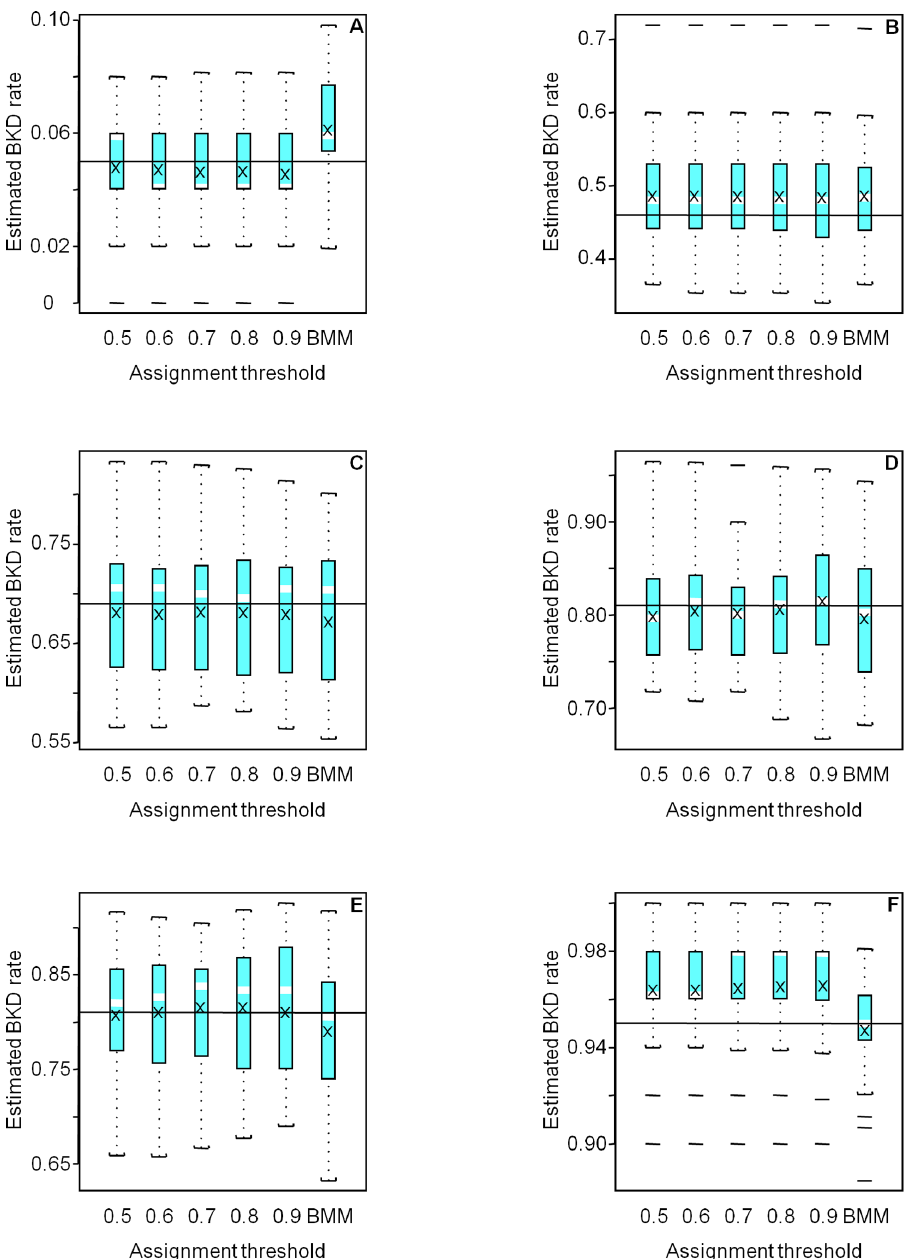
Figure 1. Boxplots of the estimated BKD prevalence rates for the 25 simulations of the positive case in Groups (A) 1, (B) 2, (C) 3, (D) 4, (E) 5, and (F) 6, using the individual assignment method and minimum assignment probability thresholds from 0.5 to 0.9. BMM represents the Bayesian mixture model, X marks the mean estimate. The solid line indicates the true BKD prevalence rate. Note the scale of the y axes vary among